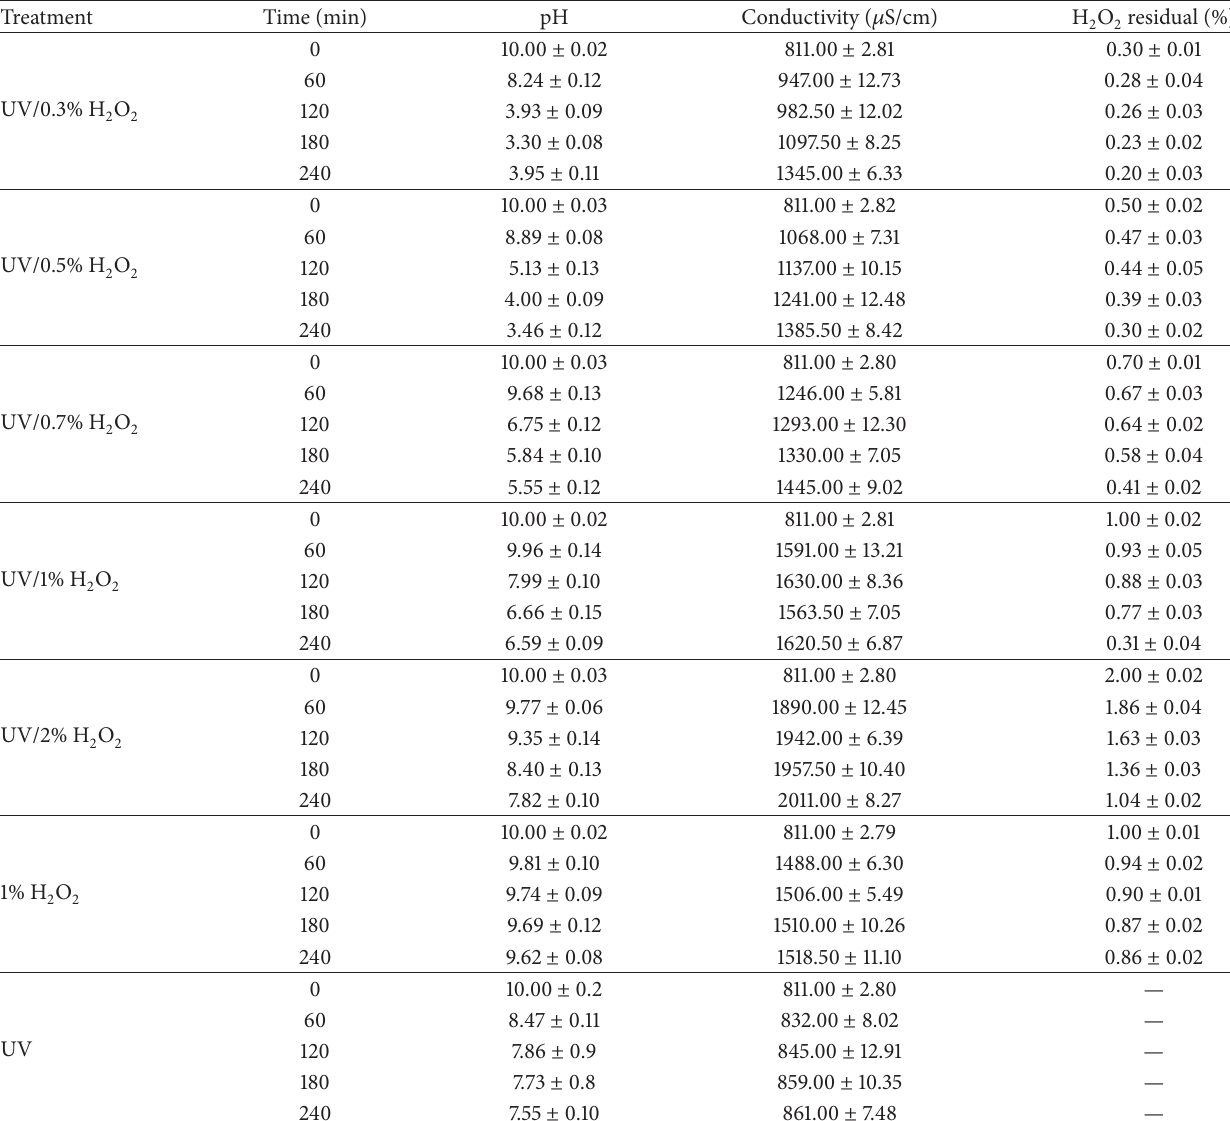
Table 1: Effect of the irradiation time and hydrogen peroxide concentration in some physical-chemical parameters. Experimental conditions: 25 ∘ C and initial pH of